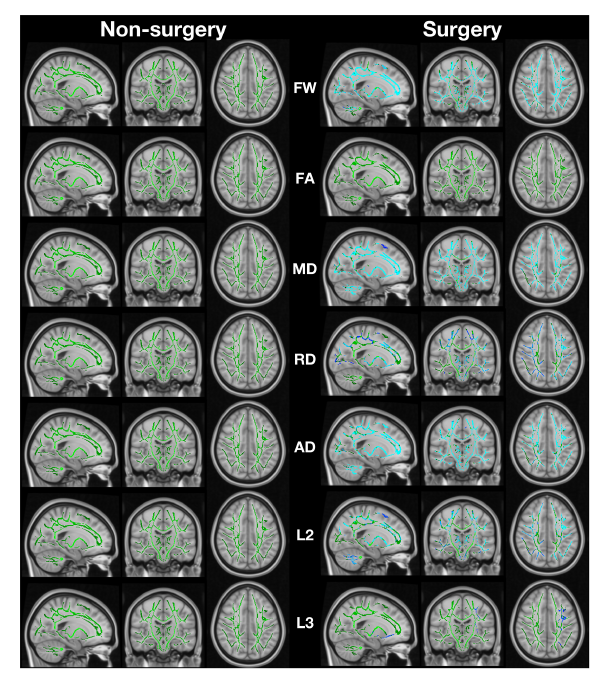
and λ 3 ), axial diffusivity (AD; calculated as λ 1 ), λ 2 (L2), and λ 3 (L3). The green regions are the white matter skeleton created by TBSS. Blue indicates regions where post > pre. Non-surgery participants had no areas of significant change while surgery participants had extensive change (FSL randomise paired t -test with 5000